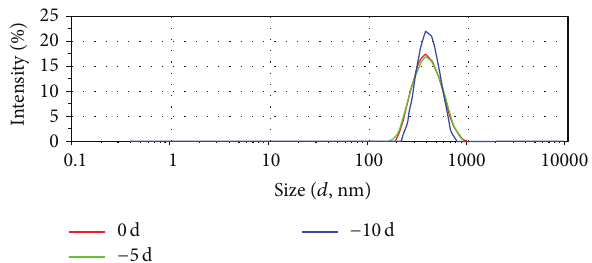
Figure 6: The influence on cubosome size distribution by high tem- perature